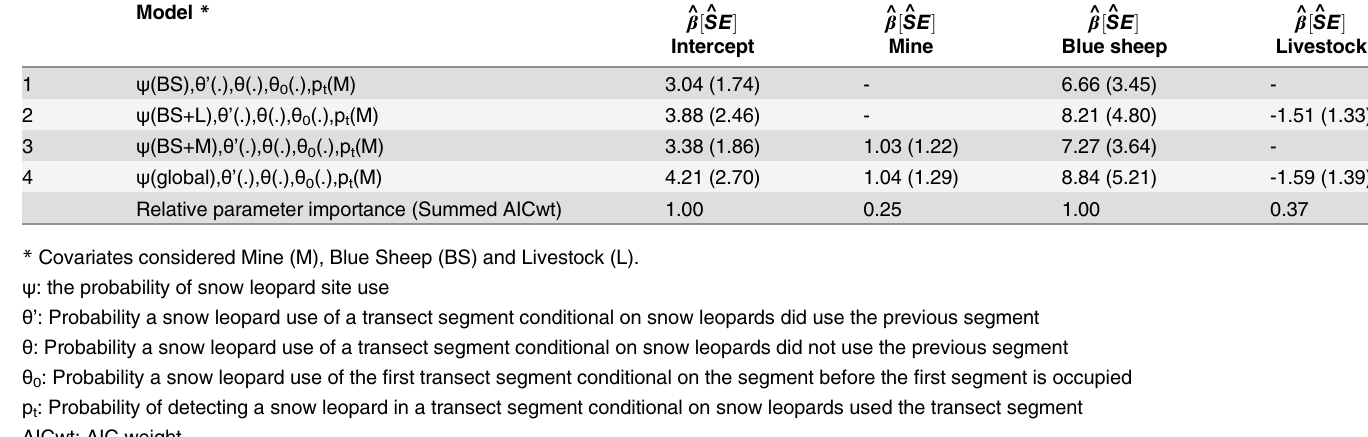
Table 2. Estimates of β coefficient values for different covariates hypothesized to influence snow leopard site use in Qilianshan National Nature Reserve, 2014. Model * ^ β ½ ^ SE